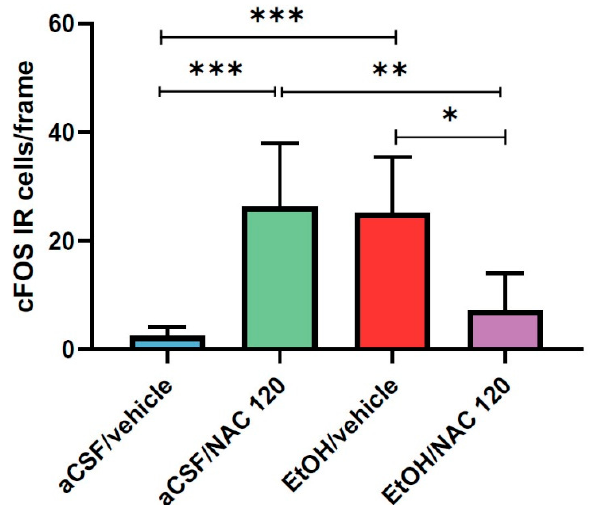
Figure 5. Effect of NAC administration (120 mg/kg) on cFOS IR-cell expression in the NAcc, 30 min prior to the intra-VTA administration of EtOH (150 nmol). Data are mean ± SD and represent the number of IR-cells per frame. Asterisks indicate statistical differences between the marked groups.